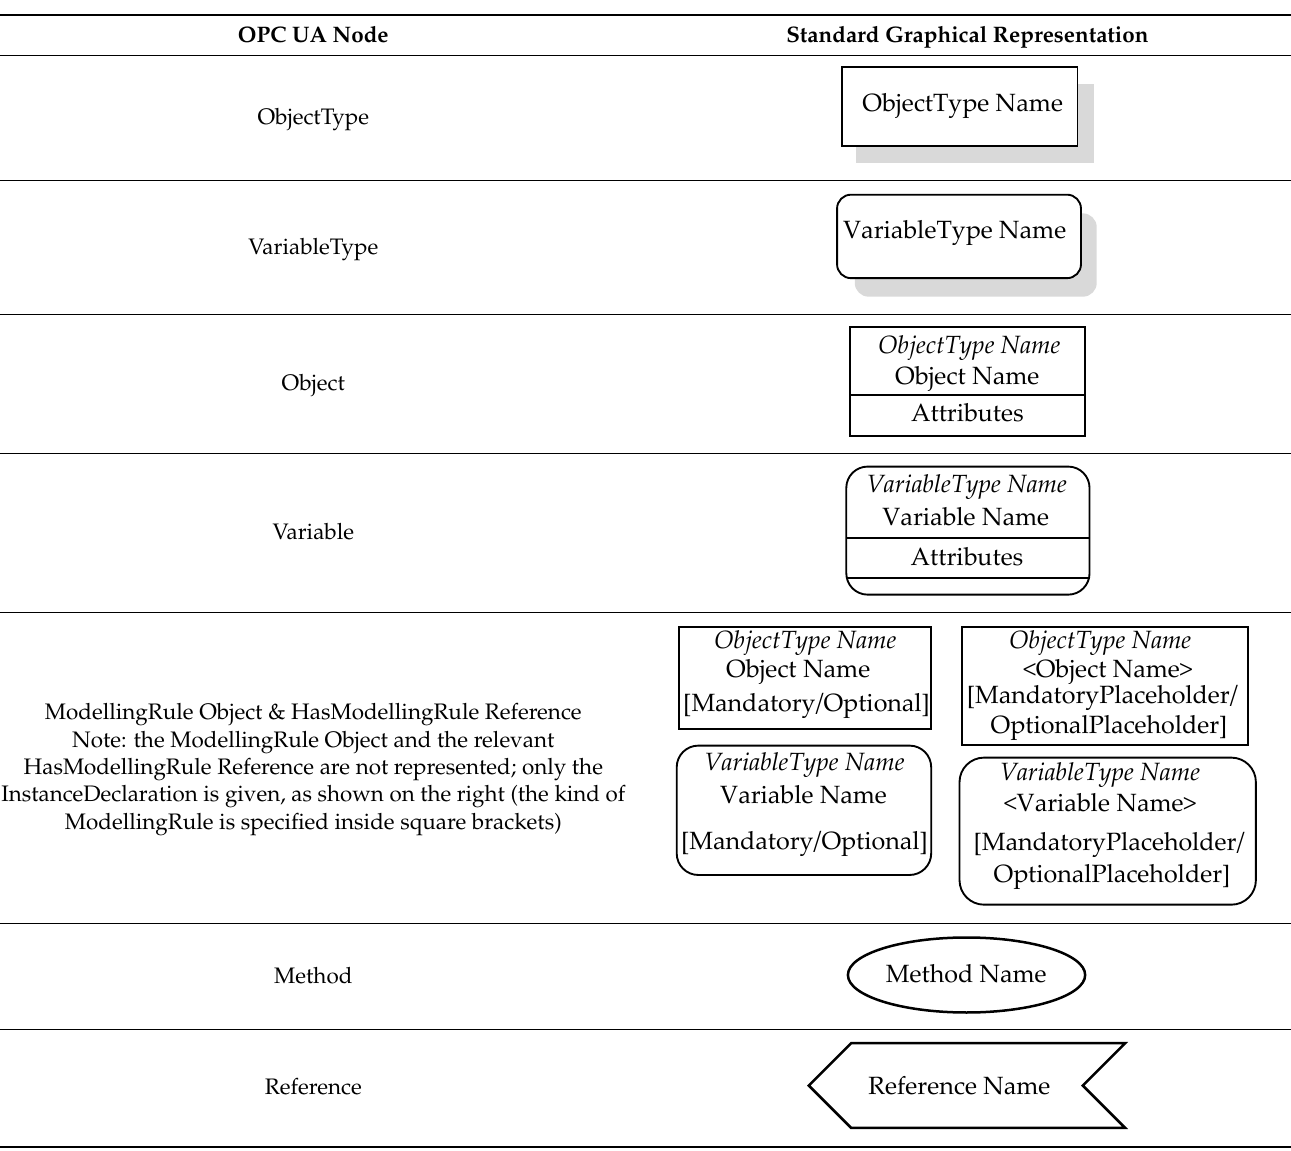
Table 1. Graphical representation of some OPC UA Nodes.